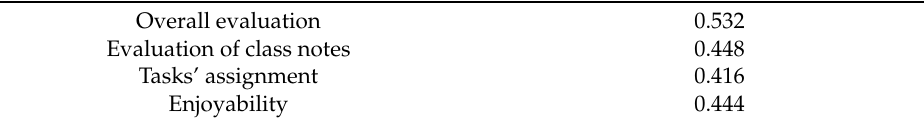
Table 2. Variables highly correlated with the module’s organisation.